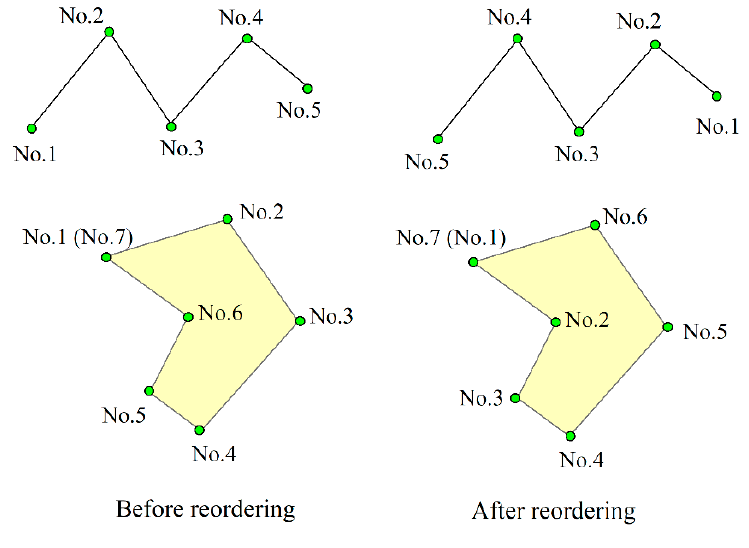
Figure 5. Object Figure 5. Object reordering.